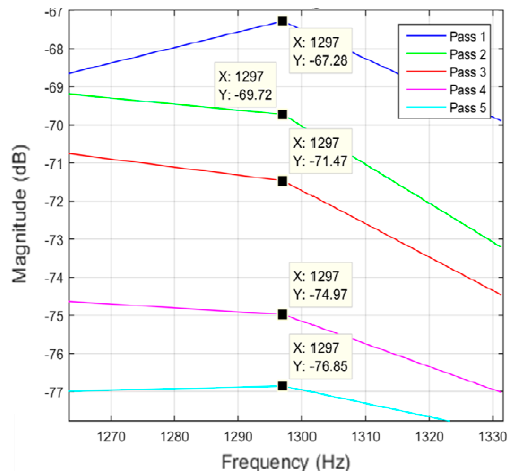
Figure 14. Vibration signal in Z direction.